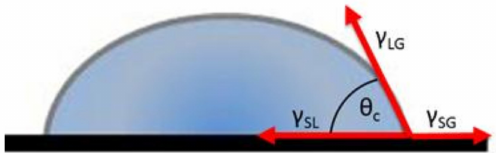
Figure 8. A scheme of a of contact angle